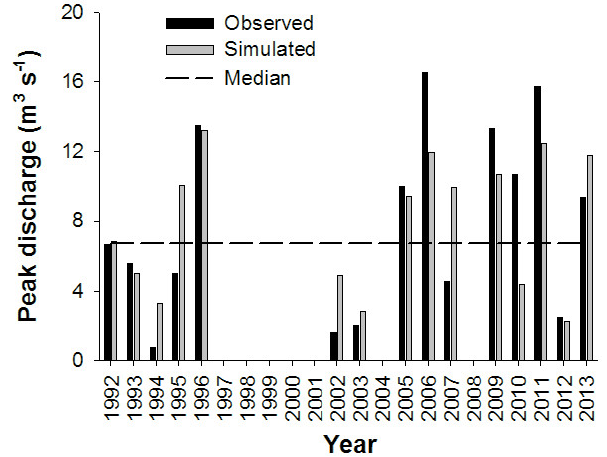
Figure 4. Comparison of observed and simulated peak discharge between 1992 and 2013 for years with good records in the HYDAT database. No data available in the HYDAT database between 1997 and 2001. The years of 2004 and 2008 were not included in the analysis since quality issues were identified in the metadata of the records.